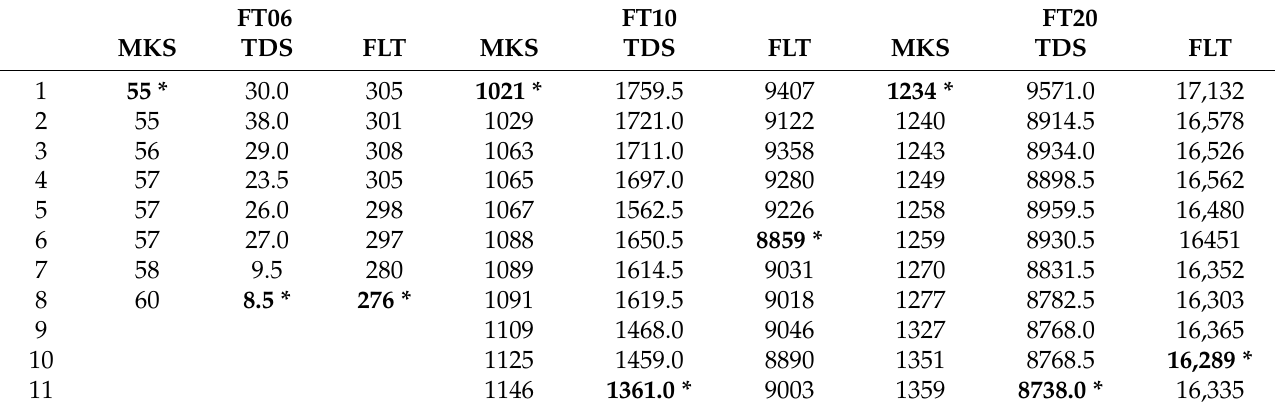
Table A7. Non-dominated front obtained by CMOTA for the JSSP instances proposed by [40].